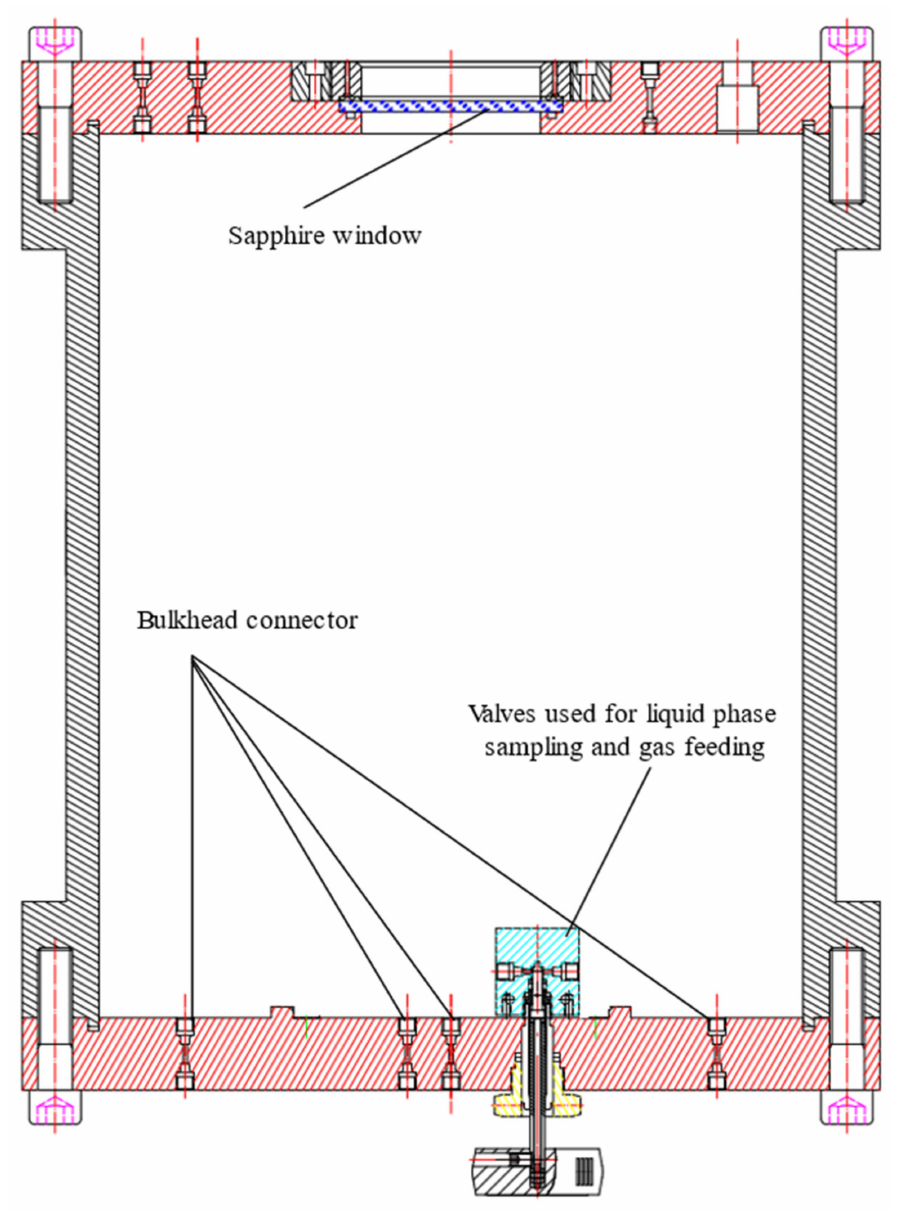
Figure 7. Schematic diagram of vacuum chamber